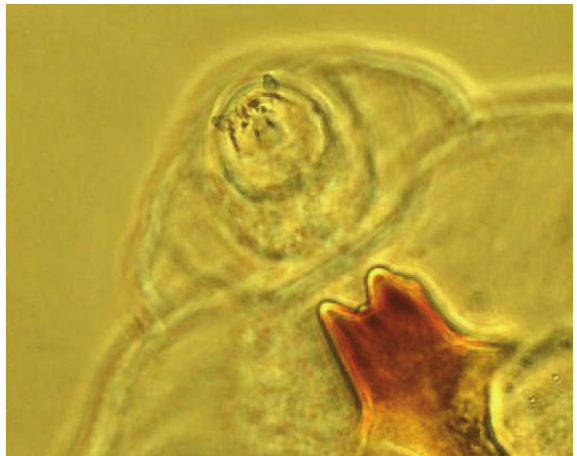
Figure 14: Ventral view of third instar head capsule showing rudimentary, paired mouthparts, and the three pronged spatula.